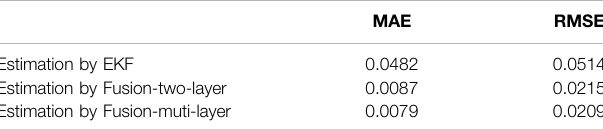
TABLE 4 | Error comparisons for